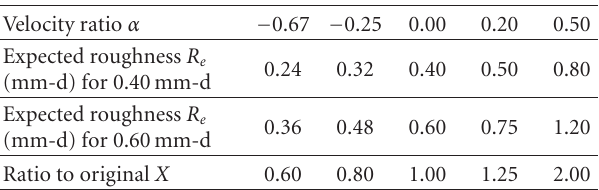
Table 2: Theoretically expected roughness R e (mm-d) and its ratio X to the original roughness (0.40 and 0.60 mm-d) according to